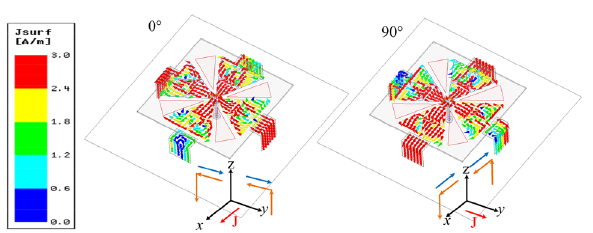
Figure 6. Current distribution on the crossed dipoles and inverted-L plates of the proposed antenna at 3.25 GHz. The blue line represents the current vector on the crossed-dipole. The orange line represents the current vector on the inverted-L